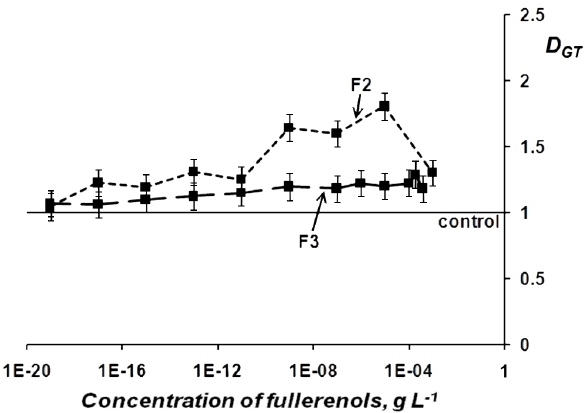
Figure 3. Detoxification coefficients D GT vs. concentration of fullerenols F2 and F3 in solutions of 1,4-benzoquinone (2.5 · 10 − 7 M) for the cellular assay.